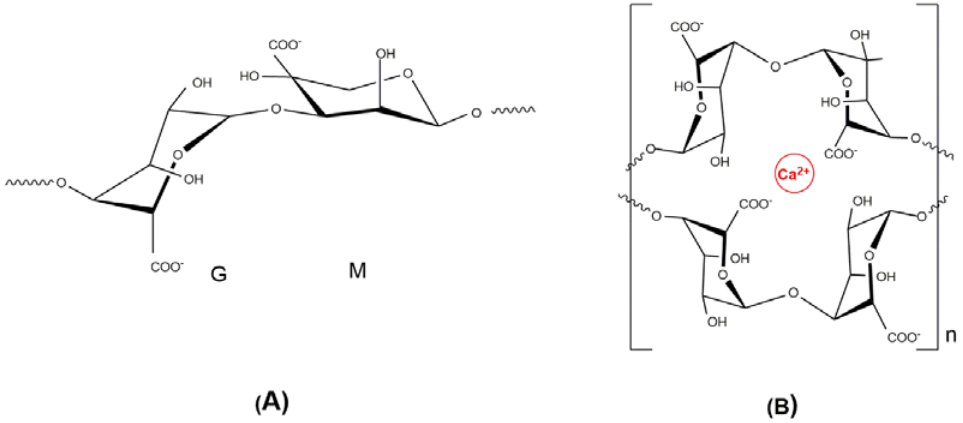
Figure 4. ( A ) Structural units in alginate. (G) Guluronic acid; (M) Mannuronic acid; ( B ) Representation of two G-blocks forming an ‘egg box’ sequence with a calcium ion.